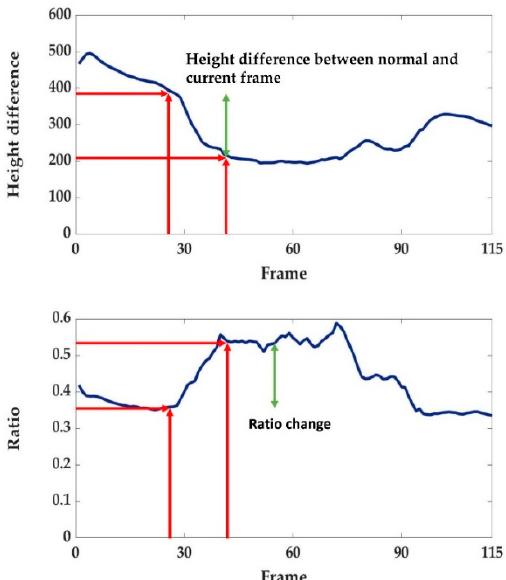
Figure 8. Vertical velocity and the corresponding threshold used to detect the start of the potential fall state.